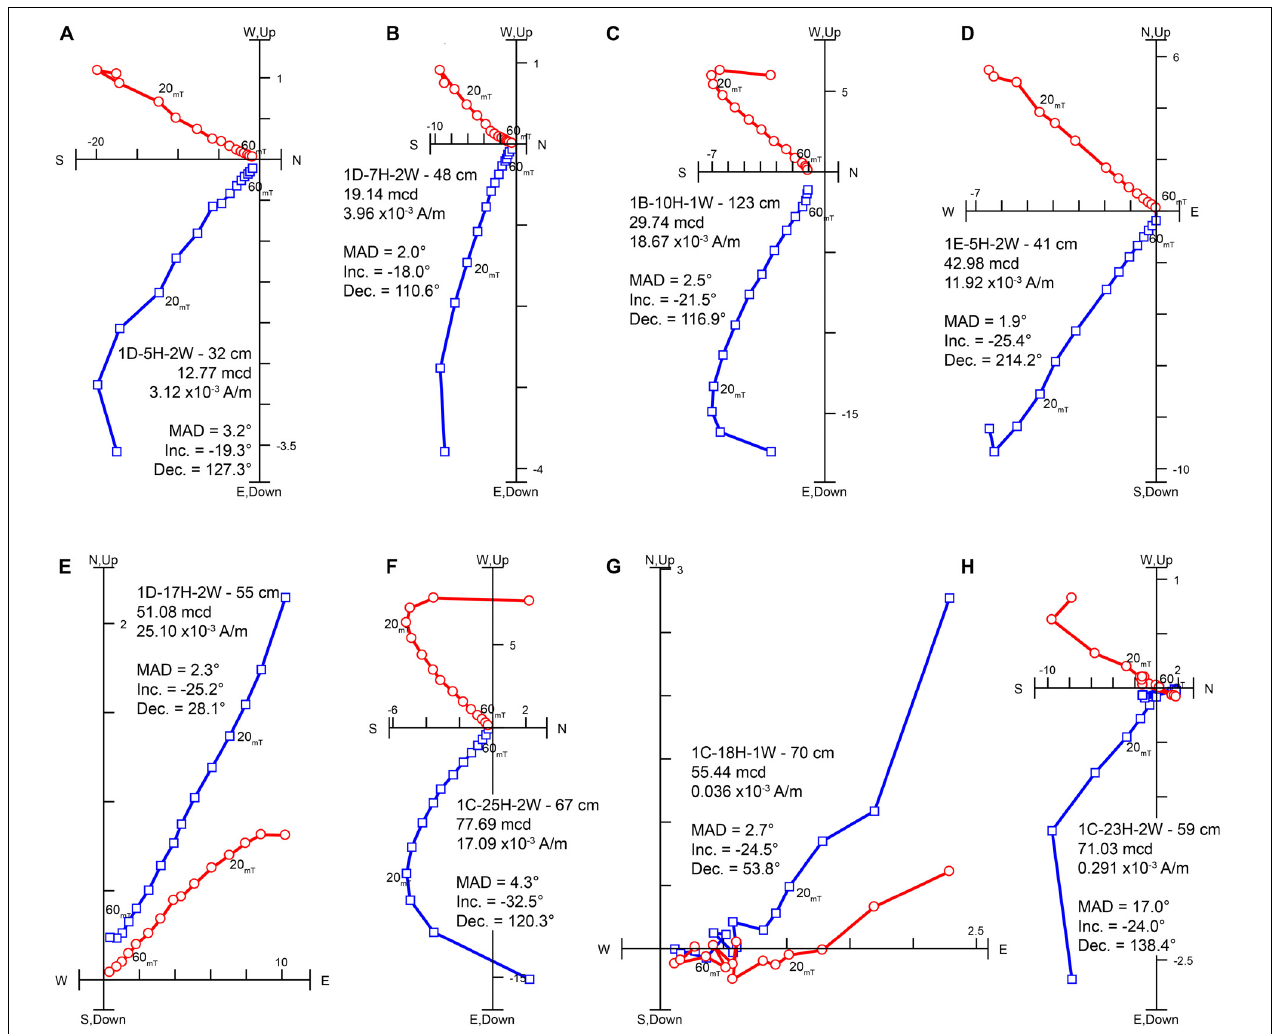
FIGURE 5 | Examples of orthogonal projections of AF demagnetization from u-channel samples. Red data and blue data represent the vertical and horizontal components of the field, respectively. The core section depth, meters composite depth, NRM 0 mT intensity value, MAD value, ChRM inclination, and ChRM declination are given. Note the stable and well-defined AF demagnetization structure and relatively low MAD values of samples with NRM 0 mT intensity values > 1 × 10 - 3 A/m (A–F) that contrasts with the more scattered AF demagnetization and higher MAD values of samples with NRM 0 mT intensity values < 1 × 10 - 3 A/m (G,H)